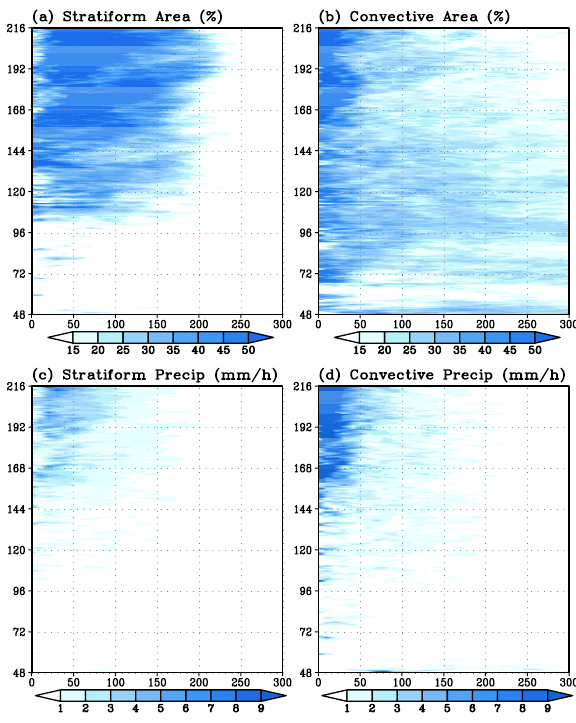
Fig. 19. Time-radial evolution of the stratiform (left) and convective (right) precipitation. The top panels show the area coverage by each rain type in percentage (%), and the bottom panels show the azimuthal mean rain rate associated with each rain type. The ordinate is time (h) and the abscissa is radius with respect to the moving pouch center (km).